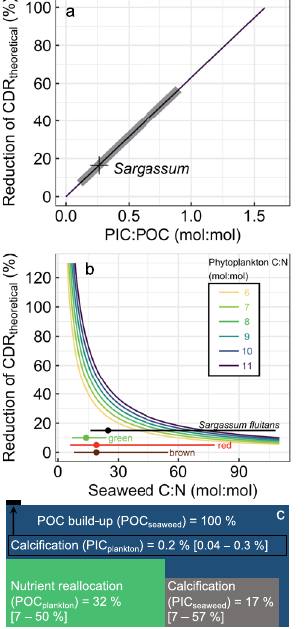
Fig. 2 Reduction of the theoretical CO 2 removal potential (CDR theoretical ) through biogeochemical feedbacks. a Reduction of CDR theoretical through particulate inorganic carbon (PIC) production by epibiont calci fi ers associated with particulate organic carbon (POC) formed by Sargassum . The purple line shows the general relationship, the grey shaded part the range of Sargassum PIC:POC observations, and the cross the Sargassum mean. b Reduction of CDR theoretical due to nutrient reallocation, which becomes more pronounced the more the seaweed carbon-to-nitrogen (C:N) ratio approaches the phytoplankton C:N ratio. We used a range of phytoplankton C:N ratios 22 as indicated by the colour code. The horizontal lines display the range of C:N in Sargassum 72 and green/red/brown seaweeds, respectively 28 (the height of the lines on the y -axis has no meaning). The solid symbols on the horizontal lines are averages ( Sargassum average = 24.8). c Summary of discounts and additions to CDR theoretical due to calci fi cation and nutrient reallocation following Eq. 1 (upper and lower bounds in square brackets). Percent reductions due to POC formed by plankton (POC plankton , blue); Percent reduction due to PIC associated with seaweeds (PIC seaweed , grey); Percent increase due to PIC associated with plankton (PIC plankton ,